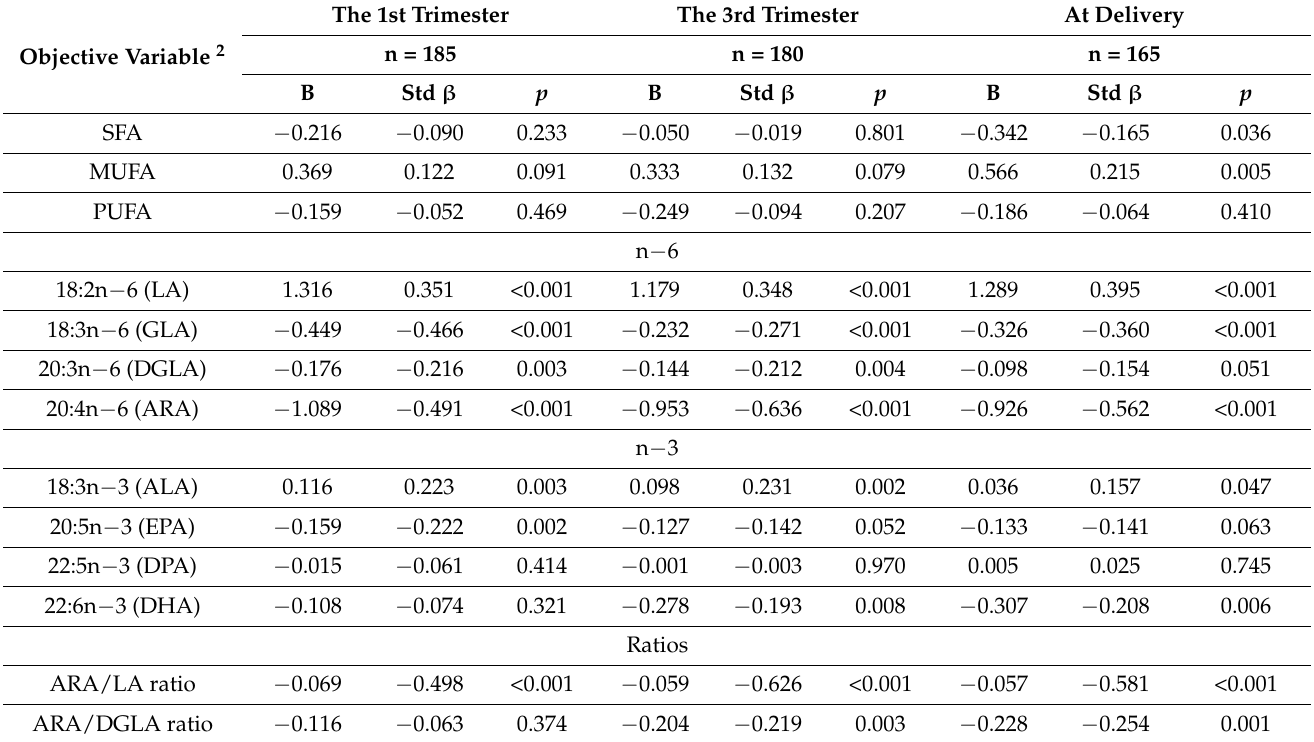
Table 3. Associations of maternal FADS1 gene polymorphisms with fatty acid compositions of maternal serum glycerophospholipids 1